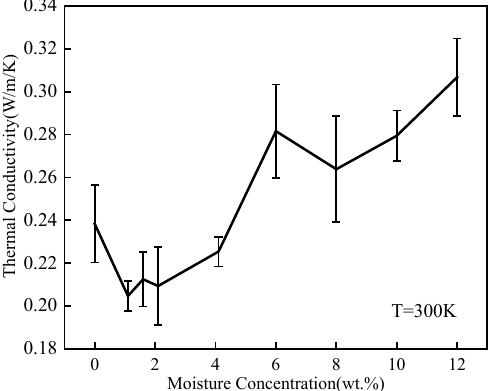
T=300K Moisture Concentration(wt.%) Moisture Concentration(wt.%) Figure 13. Thermal conductivity for various moisture